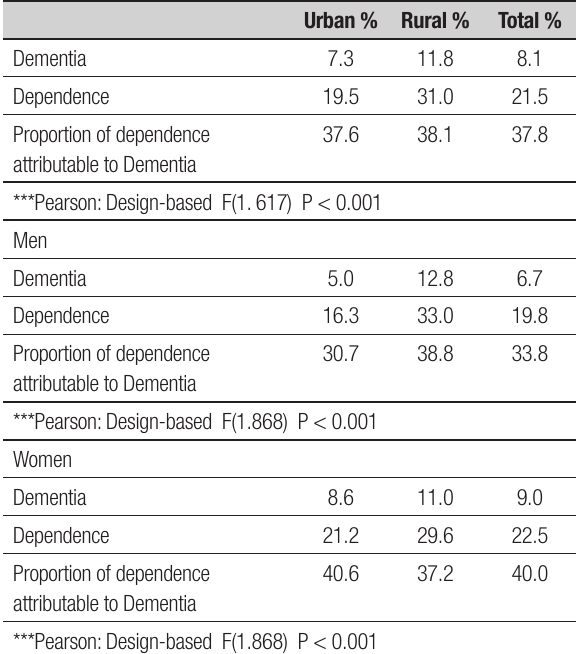
Table 3. Dementia, dependence and proportion of dependence attributable to dementia by gender and area of residence.